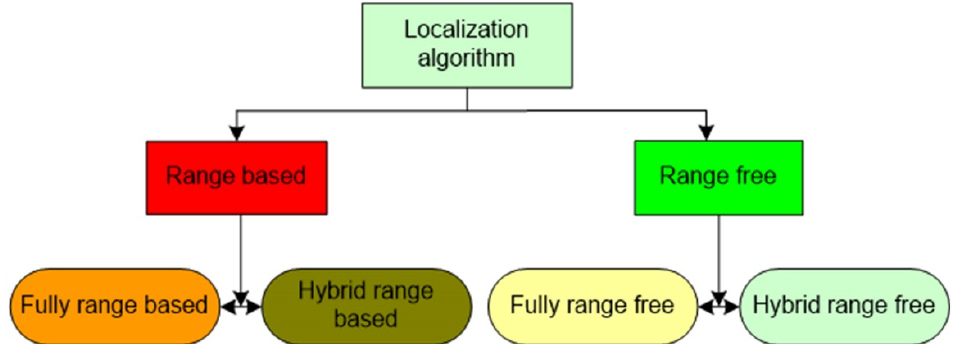
Figure 2. Classification of localization schemes for sensor networks.